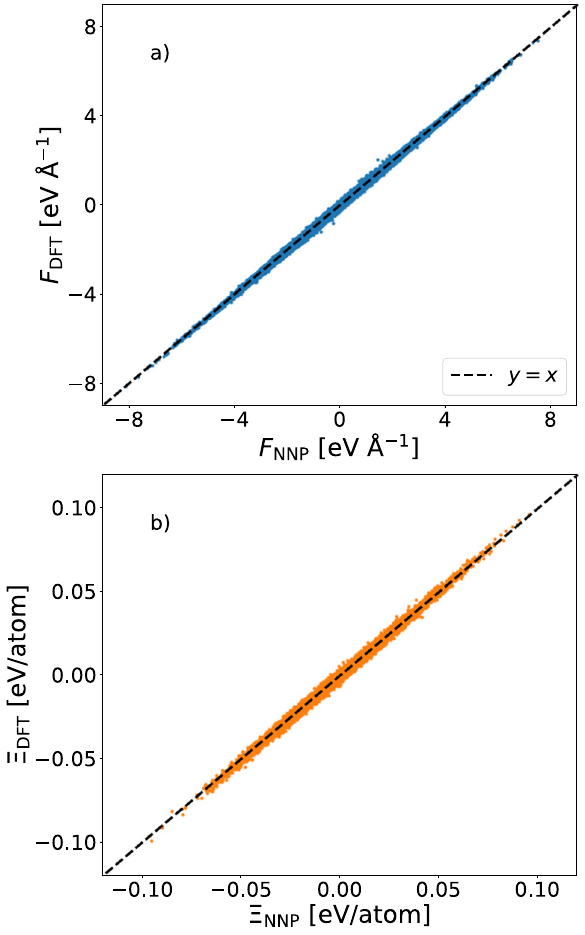
Fig. 3 Neural network accuracy. Scatter plot of the NNP forces ( a ) and off-diagonal elements of the virial per atom ( b ) vs. DFT data, for a dataset of 10,000 con fi gurations. The corresponding